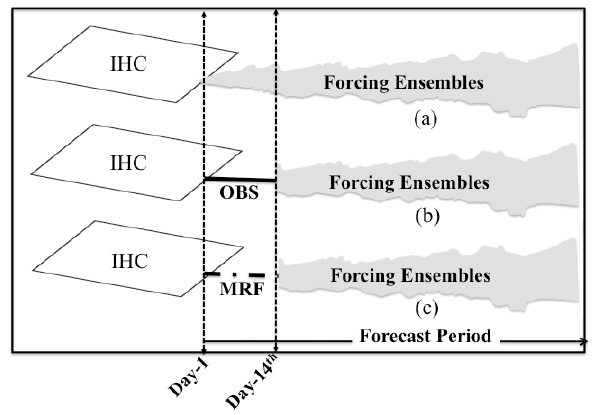
Fig. 1. Schematic showing the framework for (a) Experiment 1 Figure 1: Schematic showing the climate forecast framework for (a) Experiment-1 ( ESP ) 3 (ESP) (b) Experiment 2 (OBS Merged ESP) and (c) Experiment (b) Experiment-2 ( OBS_Merged_ESP ) and (c) Experiment-3 ( MRF_Merged_ESP ). 4 3 (MRF Merged